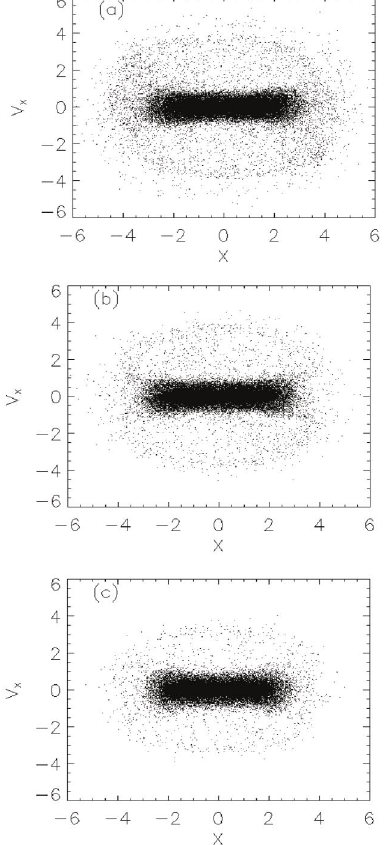
FIG. 5. Phase space distribution at last maximum rms width when S (cid:10) 300 for (cid:4) (cid:1) (cid:4) a (cid:5) 1.5, (b) 1.35, (c) 1.2.